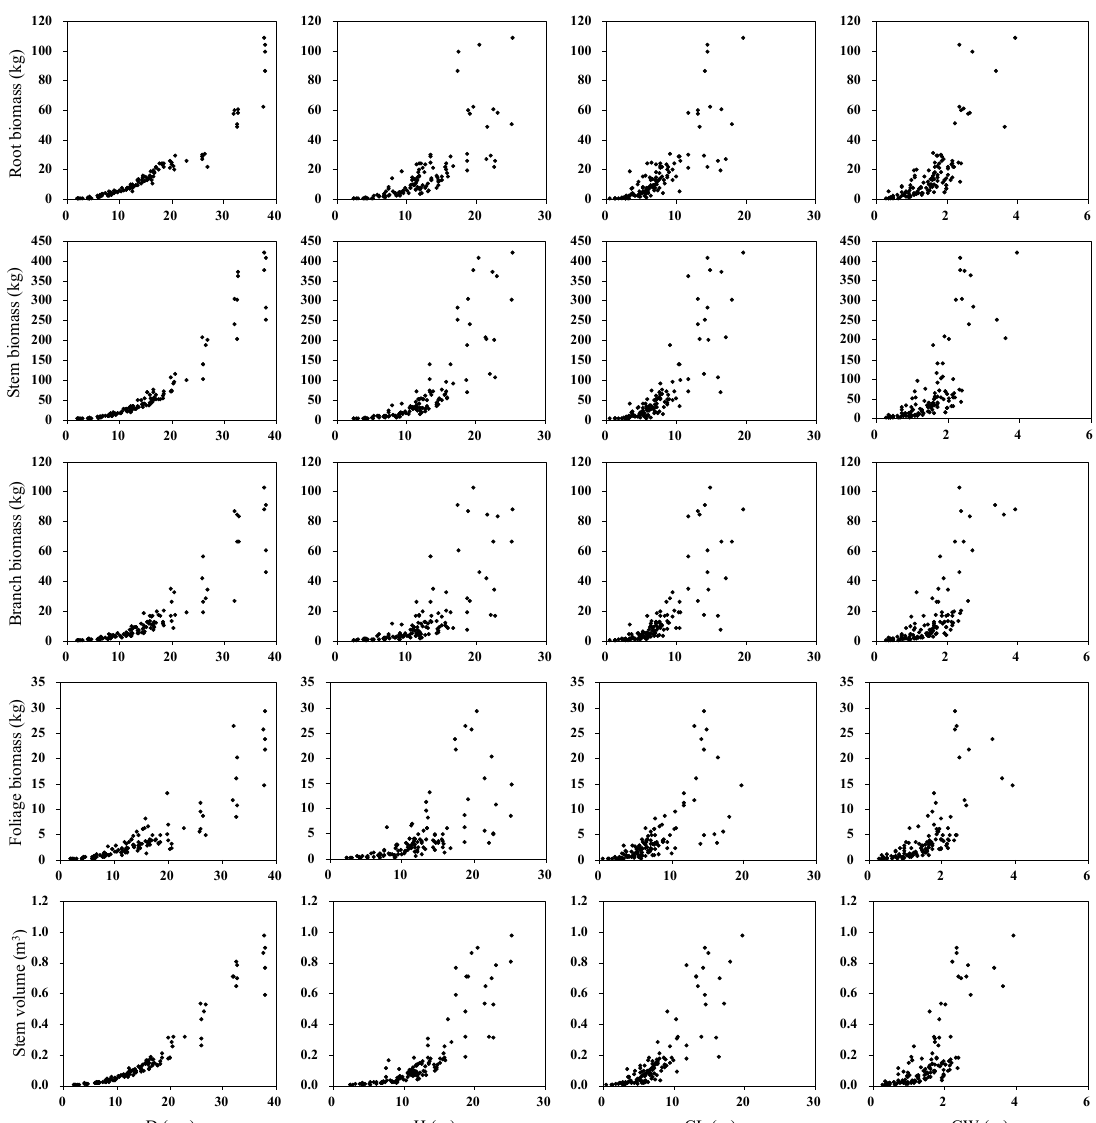
Figure 2. Relationships between the four primary biomass tissues and stem volume with the diameter at breast height ( D ), tree height ( H ), crown length ( CL ), and crown width ( CW